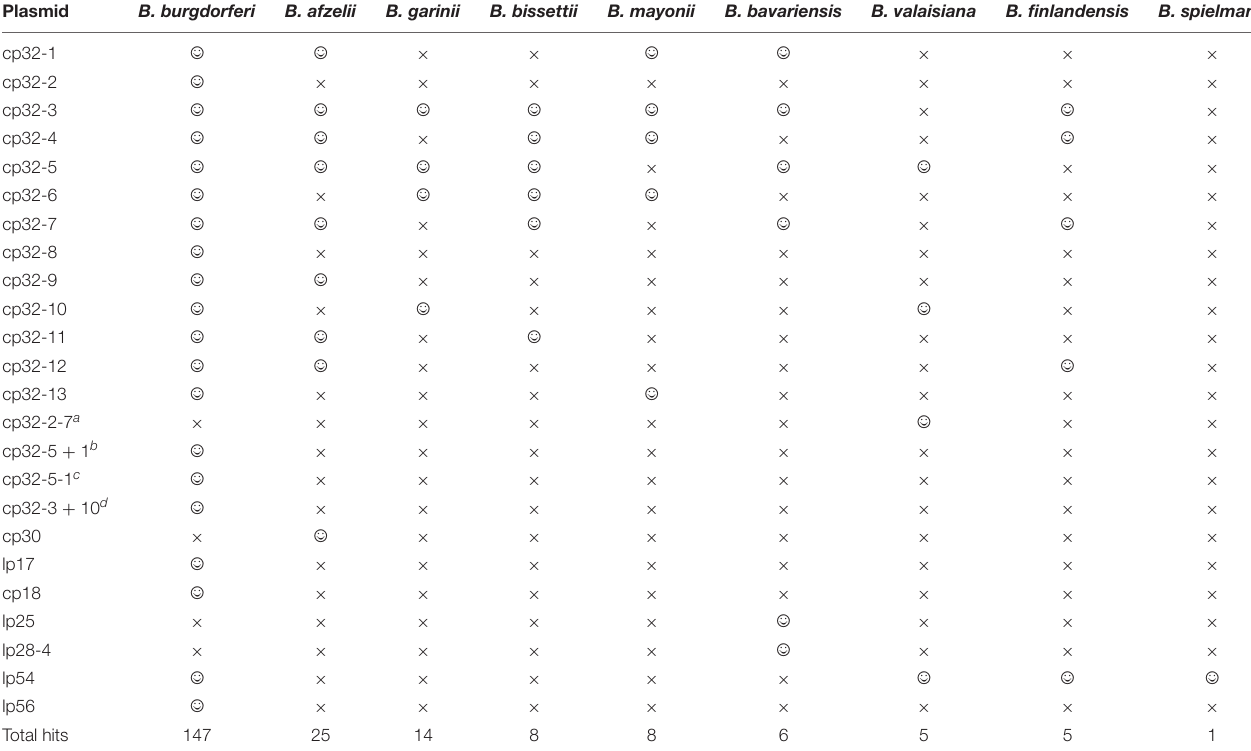
TABLE 1 | The prevalence of the terL homologs among plasmids residing Borrelia species causing Lyme disease (smiley face and ‘ × ’ to denote presence and absence of the terL homologs, respectively).